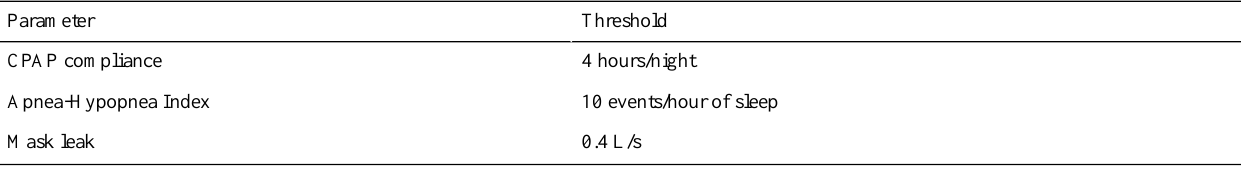
Table 1. Specifications of thresholds for each parameter